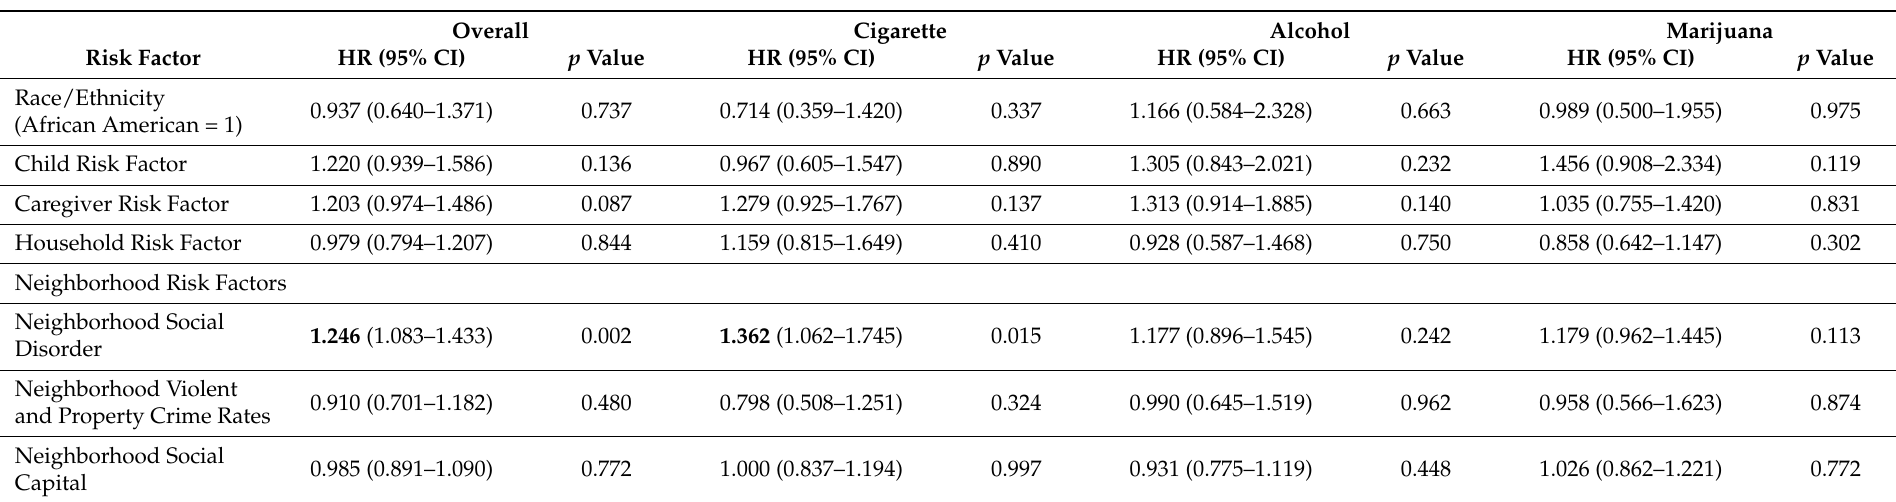
Table 3. Cox cause-specific hazards model regressing race/ethnicity, child, caregiver, household, and neighborhood risk factors on substance use